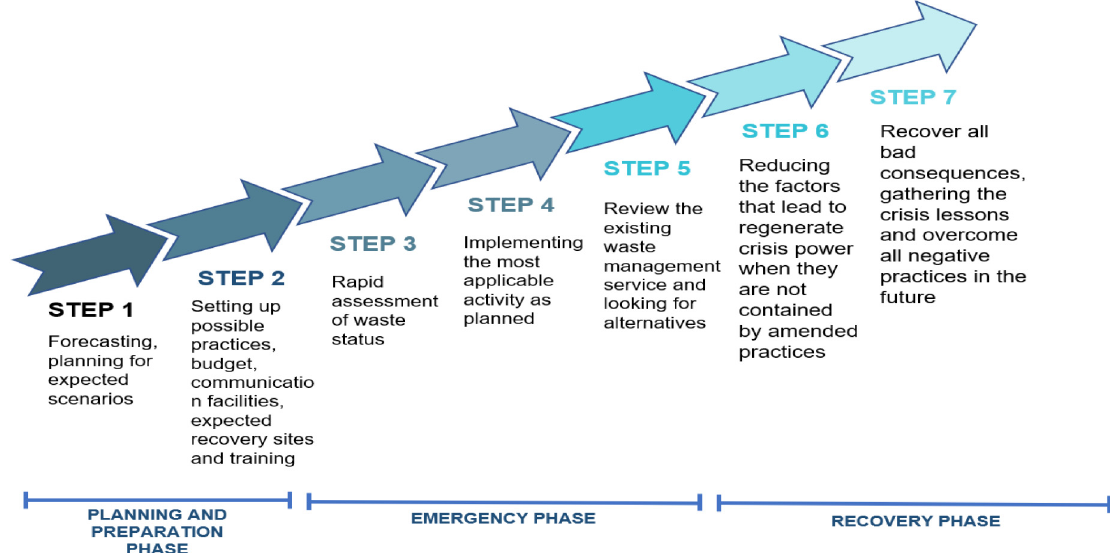
Fig. 12. summary of the contingency planning steps [Author